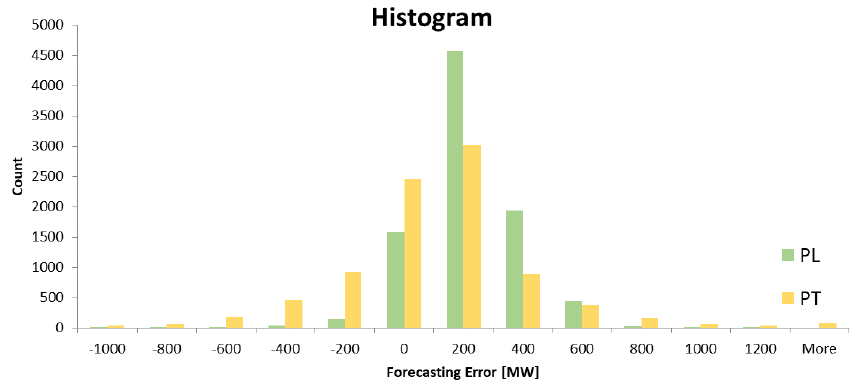
Figure 2. Aggregated wind power error forecast distribution for Poland and Portugal, 2016. Table 3. Statistical description of the wind energy forecast error for Poland and Portugal in 2016.